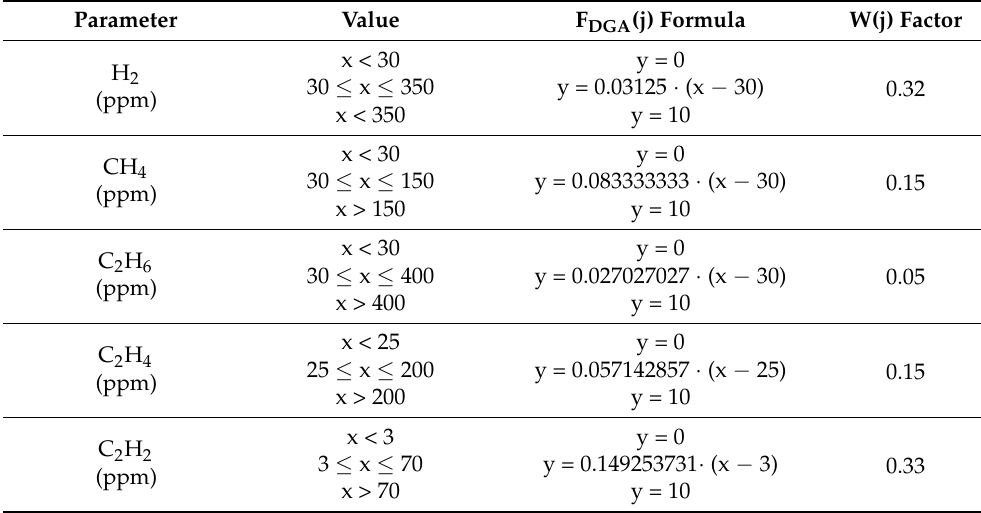
Table 5. The individual formulas and weighting factors used to evaluate the dissolved gas content in oil. Parameter